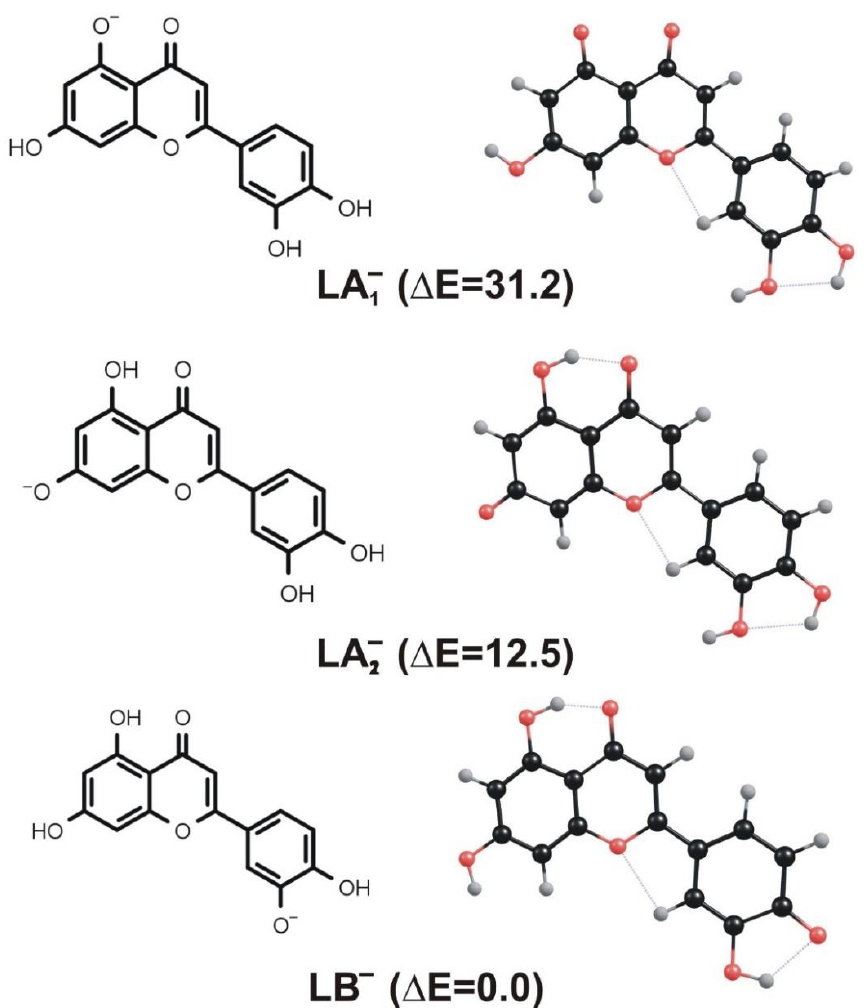
Figure 3. Equilibrium structures of LA 1- , LA 2- , and LB - anions resulting from deprotonation of neu- tral luteolin. Relative energies (ΔE) of these isomers are given in kcal/mol. Even though the anionic LA 1- , LA 2- , and LB - isomers considered differ with one an- other only by the position of deprotonated hydroxyl group, their total electronic energies vary significantly. Namely, the LB - anion corresponds to the lowest energy structure, while the relative energies of LA 1- and LA 2- isomers were found to be larger by 31.2 and 12.5 kcal/mol, respectively (see Figure 3). If one considered the possible existence of these isomeric structures in the equilibrium conditions, such relative energies would clearly in- dicate that the mixture should be dominated by the LB - species, whereas the presence of LA 1- and LA 2- structures in the bulk should be considered unlikely. However, the depro- tonation of luteolin caused by the negative ion electrospray ionization technique likely leads to the formation of all isomeric structures depicted in Figure 3, which are then the subjects of the fragmentation processes that follow. Therefore, a thorough study of depro- tonated luteolin fragmentation has to cover the paths which involve all LA 1- , LA 2- , and LB - isomers as starting substrates, more so because it is not experimentally feasible to recog- nize the isomer type while performing ESI-MS. In the following sections, we present the energy profiles that correspond to the fragmentation channels resulting in the formation of both 1,3 A - (at m / z 151) and 1,3 B - (at m / z 133) anions observed in the ESI-MS experiment. 3.3. Fragmentation Paths for LA 1 - Isomer (Leading to 1,3 A - Product at m / z 151)